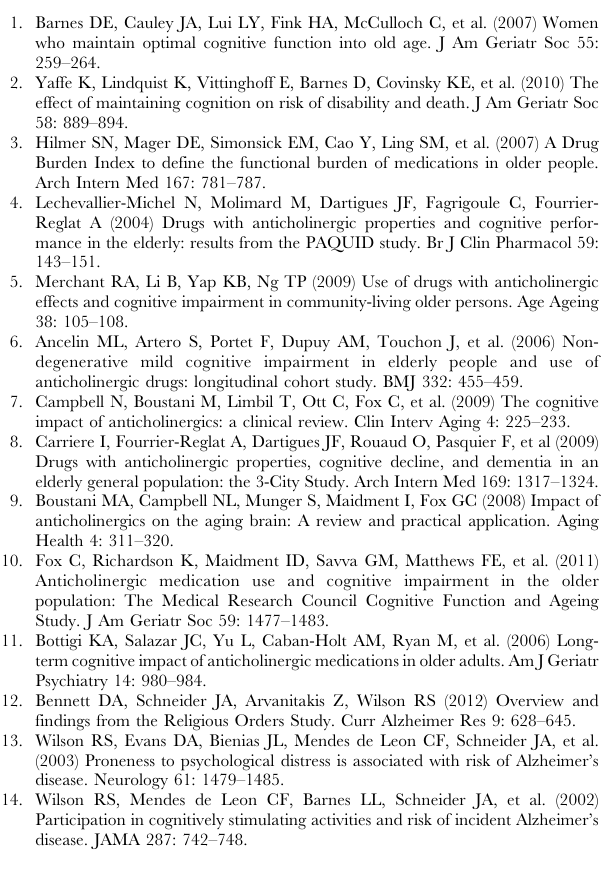
Table S1 Technical Supplement for Model Construction with Change Point for Initiation of a Medication with Anticholinergic Activity. Table S2 Values given to time terms at each visit for persons classified by use of medication with anticholinergic activity. Table S3 Use of terms to determine average annual rate of change in cognitive function for participant classified by use of a medication with anticholinergic activity. Table S4 Effect of baseline covariates on modifying trajectory of global cognitive function in incident users (n= 237) of a medication with anticholinergic